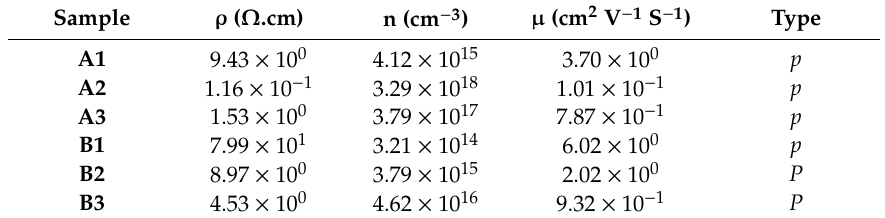
Table 1. Electrical properties of the Cu 2 Mg x Zn 1 − x SnS 4 ( x = 0.2) thin films annealed at di ff erent annealing